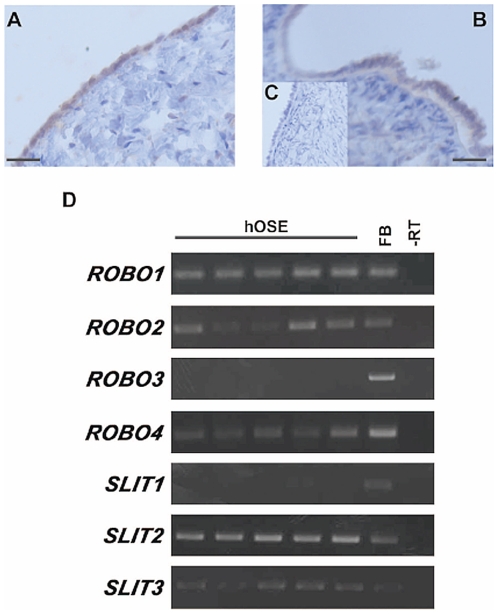
Expression analysis of the SLIT and ROBO gene families in human OSE (hOSE).
A) Light-field microscopy of ovary showing specific staining for SLIT2 (brown) in the OSE. B) Likewise positive ROBO1 (brown) staining was also observed in the OSE. C) No staining was observed in negative controls. Scale bars represent 100 µm. D) RT-PCR for SLITs and ROBOs in cultured hOSE. With the exception of SLIT1 and ROBO3 the members of the SLIT and ROBO families were expressed in hOSE. FB = Fetal Brain positive control; -RT = RT negative negative control.